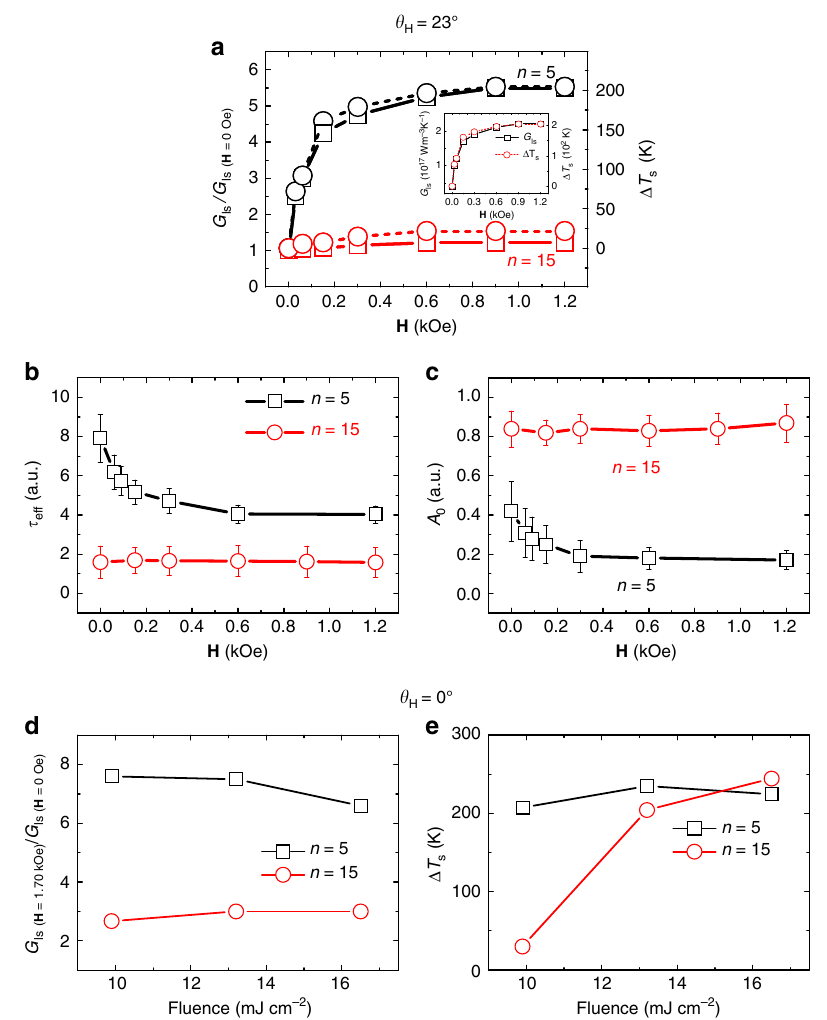
Fig. 4 Field- and fl uence-dependent behavior. At θ H = 23°, a Field-dependent G ls / G ls( H = 0) (open square solid line) and Δ T s (open circle dotted line) for n = 5 (black) and 15 (red). Fitted values of τ eff b and A 0 c under various fi elds for n = 5 (open square) and 15 (open circle) samples. Fluence-dependency at θ H = 0° for d G G Δ T n = 5 (open square) and 15 (open circle) ls( H = 1.70 kOe) / ls( H = 0) and e s for